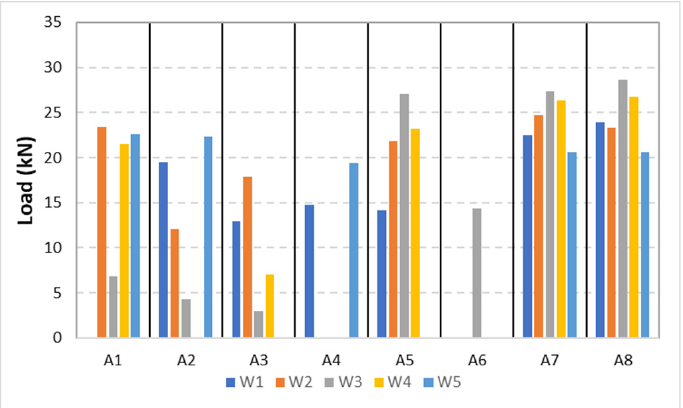
Figure 9. Maximum load in each position.